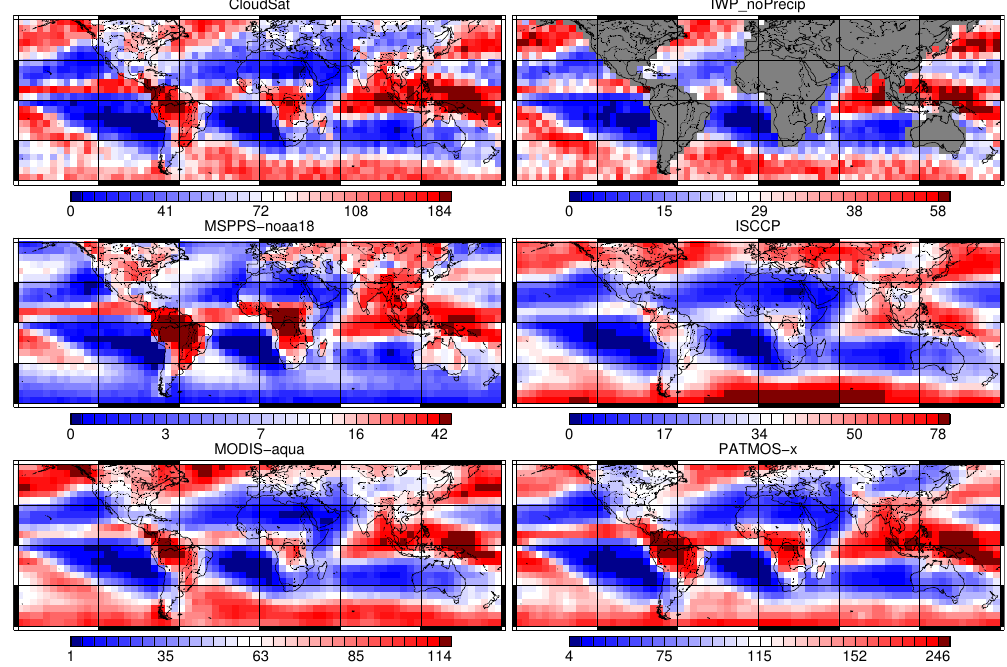
Fig. 5. IWP spatial distribution of satellite data for their common temporal range (July 2006 to April 2008). Based on a polar colour table, the colour “steps” represent 100 × 1 -percentile intervals, the “colours” are in reference to the percentile box that contains the mean (which 32 is coloured white), and the values in the legend are the absolute IWP [g / m 2 ], corresponding to the percentiles at 0%, 1st quartile, median, 3rd quartile and at the 100 × 31 percentile ( 96%). See also Table 3 for the gridded statistics referred here. 32